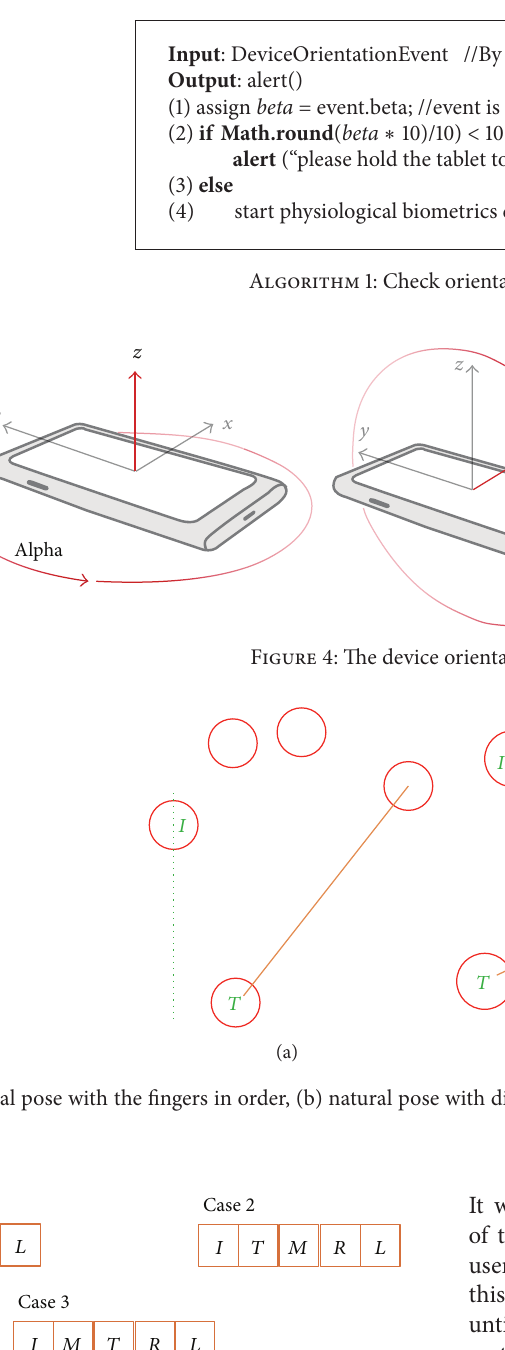
checking hand-side. There will be five cases with the thumb in different positions; please refer to Figure 6. After determining the fingers relative position, the relative distances of thumb to index and little finger are used to estimate the